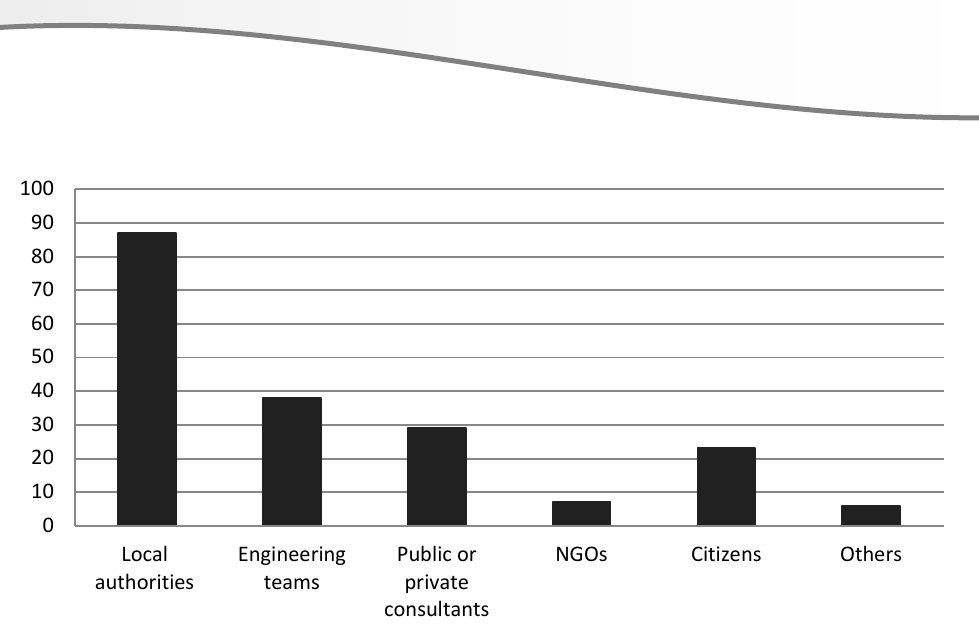
Figure 9: The contribution on planning the actual transport system (Sum of scores, that were expressed in the questionnaire on a 1 to 5